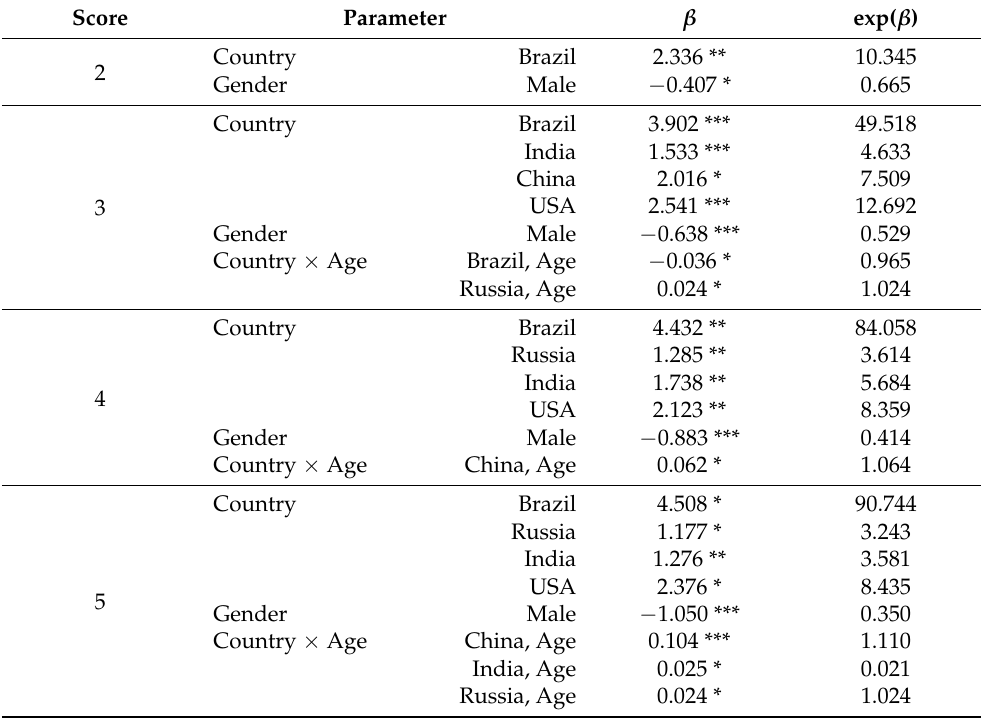
Table 2. Parameters of the multinomial logistic model fitted to the data. The ordinal dependent variable is the statement “ animals used for food have approximately the same ability to feel pain and discomfort as humans ,” modeled as a function of the independent variables “Country”, Gender” and “Age” together with the interactions between these. Only significant ( p < 0.05) parameters are shown. Score 1 is used as reference in the